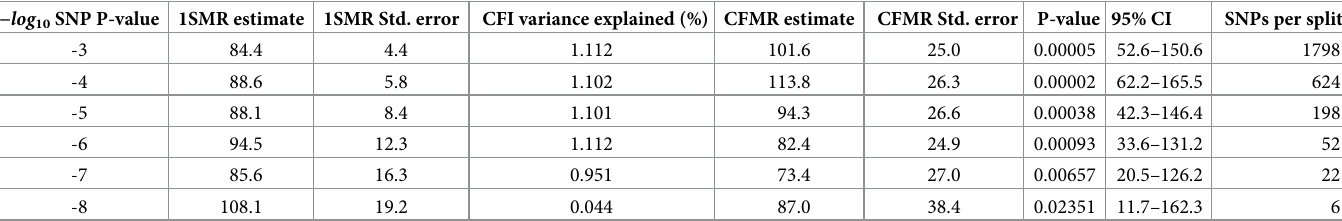
Table 1. CFMR estimates of maternal pre-pregnancy BMI on newborn’s birth weight per 1 SD increase in maternal pre-pregnancy